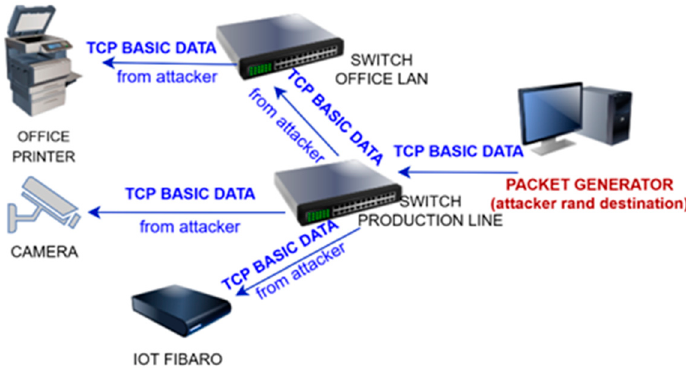
Figure 9. A visual illustration of the scenario 5 attack.